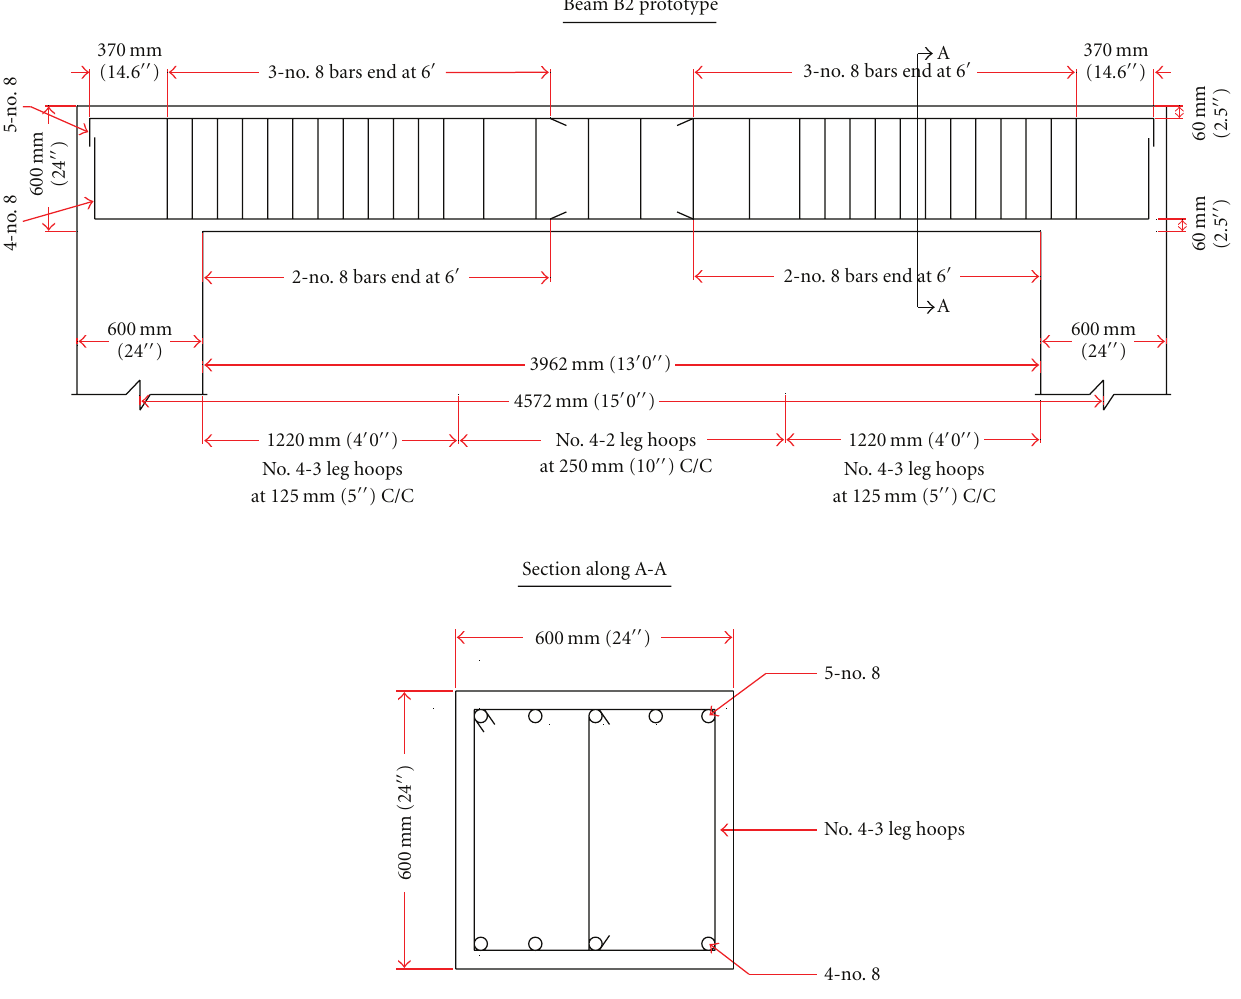
Figure 3: Reinforcement detail of prototype beam